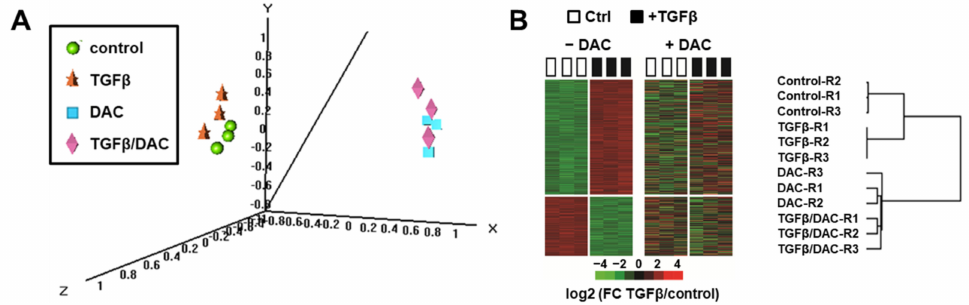
Figure 2. Clustering analysis of gene expression profiles of SNU449 cells upon TGF β and decitabine (DAC) treatments. ( A ) Multidimensional scale (MDS) plot of samples colored by experimental groups, based on the expression of 28,101 probes (global gene expression profiles). ( B ) Hierarchical clustering analysis based on the expression of 740 probes differentially expressed in SNU449 cells upon TGF β treatment ( p < 0.001 and fold-change FC > 2) in the absence of decitabine ( − DAC, left heatmap). The right heatmap and the dendrogram demonstrate that DAC co-treatment abolished the modulation of TGF β responsive genes (R1–3: Replicates